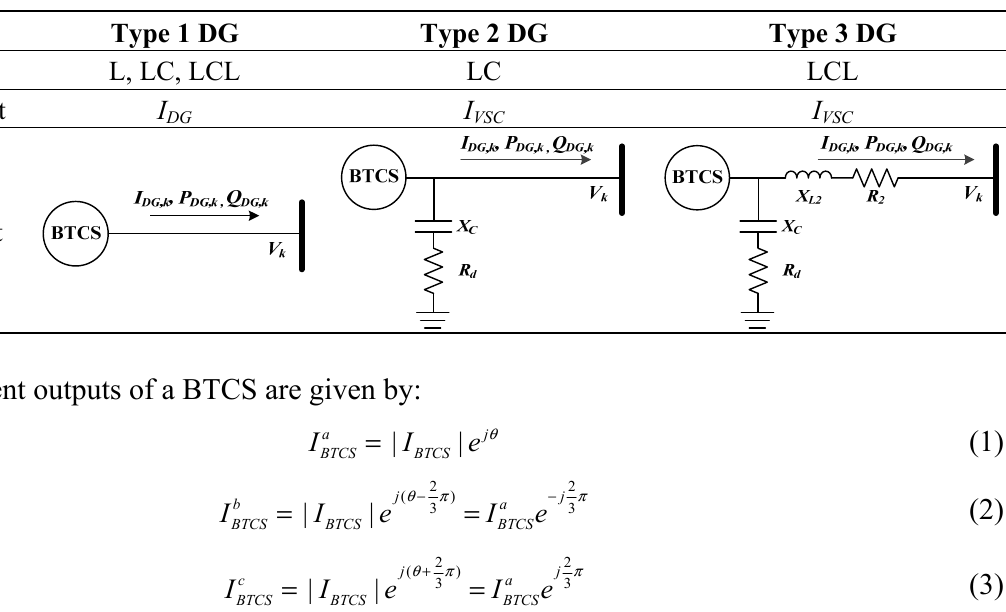
Table 1. DG types and corresponding equivalent